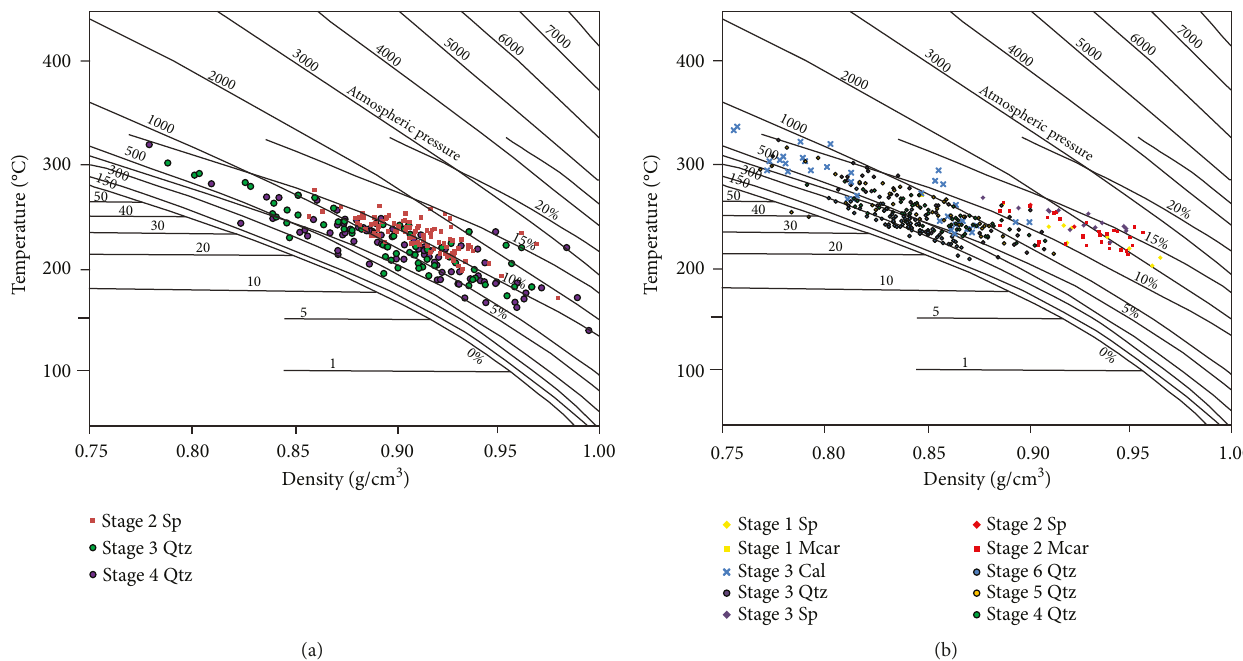
Figure 14: (a) The NaCl – H O system ρ -T-D diagram of the di ff erent stage fl uids in the Keyue Sb – Pb – Zn – Ag deposit (modi fi ed from 2 Chen et al. [67]). (b) The NaCl – H O system ρ -T-D diagram of the di ff erent stage fl uids in the Zhaxikang Sb – Pb – Zn – Ag deposit 2 (modi fi ed from Yu